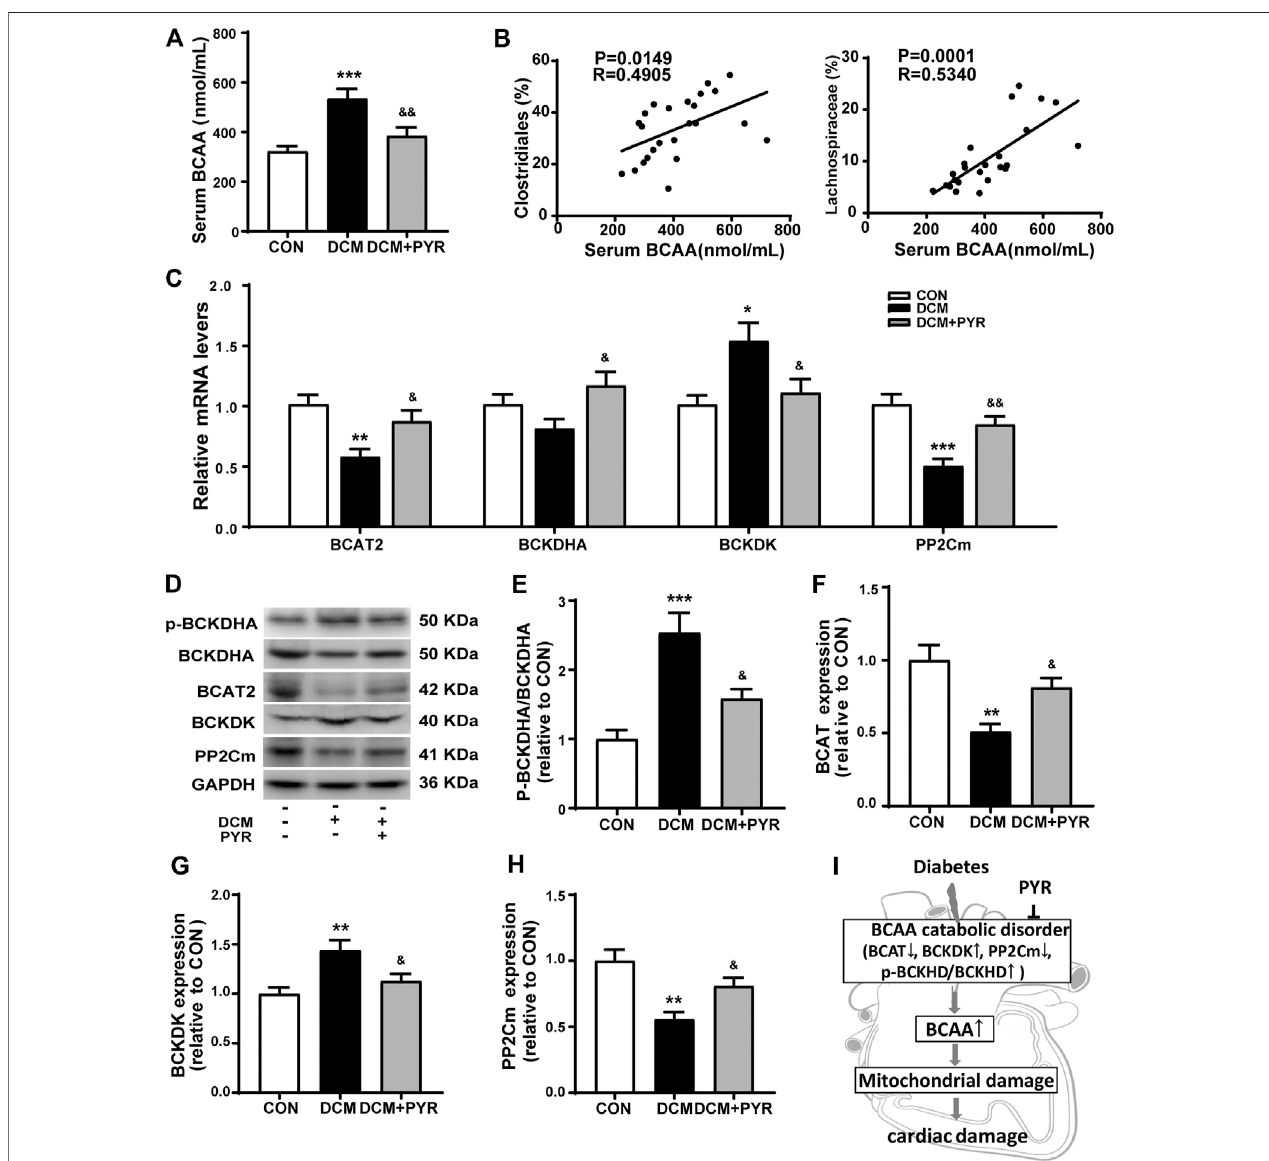
FIGURE 5 | Pyridostigmine improved BCAA catabolism in cardiac tissue in diabetic cardiomyopathy mice. (A) Serum BCAA concentrations. (B) Correlation analysisbetween therelativeabundance ofgutbacteria,including Clostridiales and Lachnospiraceae, and serum BCAA levels. (C) Real-time PCR analysisofthe mRNA expression of BCAT2, BCKDHA, BCKDK, and PP2Cm in cardiac tissues. (D – H) Protein expression of p-BCKDHA, BCKDHA, BCAT2, BCKDK, and PP2Cm in cardiac tissue. (I) The BCAA catabolism pathway in cardiac tissue was impaired in diabetic cardiomyopathy mice. Data are expressed as the mean ± SEM. n (cid:1) 6 – 8. * p < 0.05, ** p < 0.01, *** p < 0.01, vs. CON; & p < 0.05, && p < 0.01, vs.